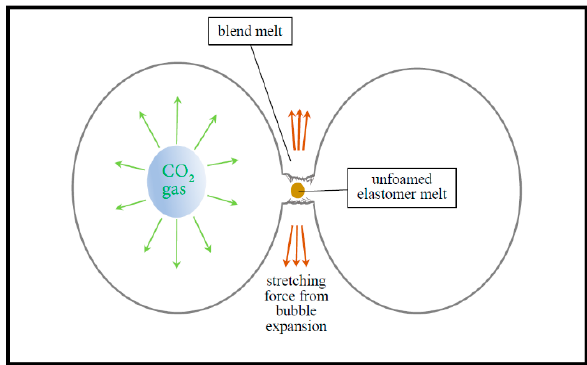
Figure 9. Schematic diagram of the pore opening mechanism during the foaming process of incompatible SAN/CPE blends.